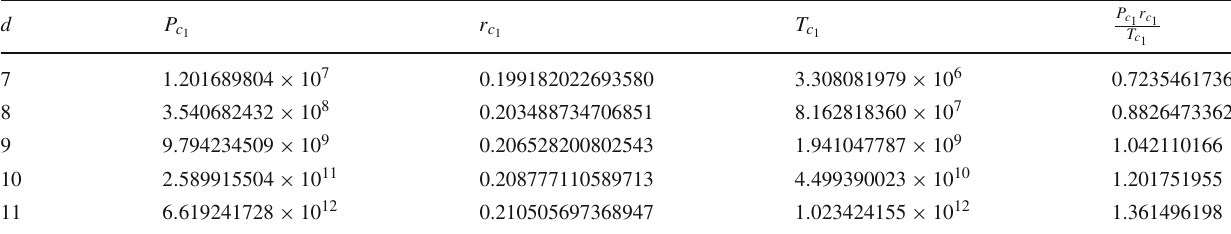
Table 7 (Hot) Hyperbolic black holes: k = − 1, q = 1, m = 1, c 0 = c 1 = c 2 = c 3 = c 4 = 1 and α = 0 . 01